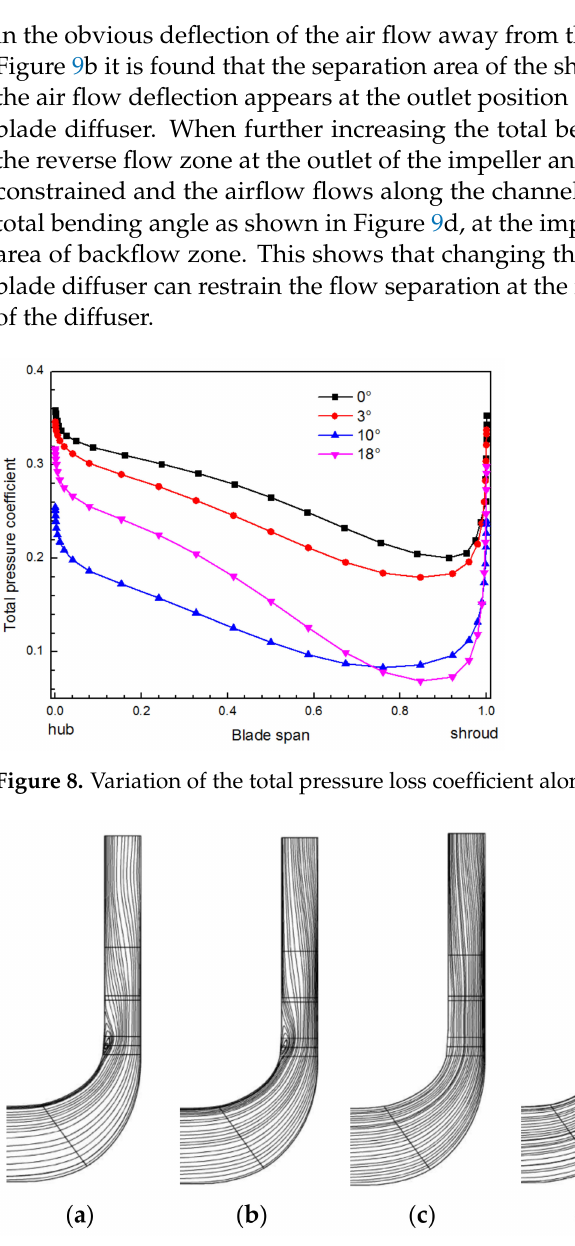
Figure 9. Meridian streamline of centrifugal compressor. ( a ) 0 ◦ model; ( b ) 3 ◦ model; ( c ) 10 ◦ model; and ( d ) 18 ◦